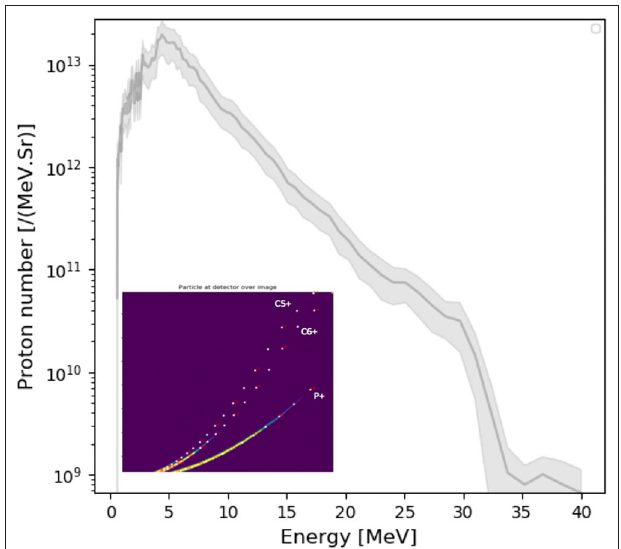
FIGURE 2 | Proton energy distribution measured by the TP spectrometer for the reference shot in which only the 25- µ m-CH target was used (laser at 1.4 kJ/2.6 ps). This shows acceleration of a very high number of protons ( > 10 13 sr − 1 ) with energies in the 1–10 MeV range. Insets shows the actual ion traces on the IP detector.